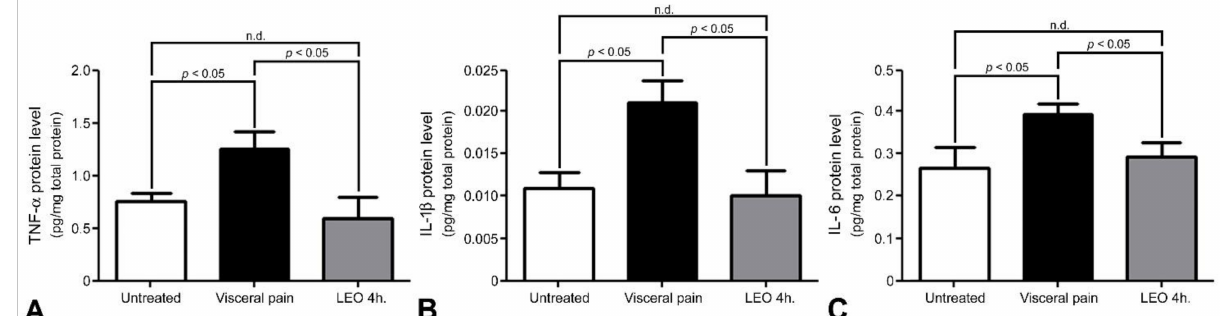
Figure 7. Histograms show the pro-inflammatory cytokine levels in the CeA of the untreated, visceral pain, and OS groups receiving LEO for 4 h. Note that visceral pain significantly increased TNF- α ( A ), IL-1 β ( B ), and IL-6 ( C ) concentrations in the CeA as compared to the untreated group. Also note that in animals suffered from visceral pain and who received LEO, the level of pro-inflammatory cytokines was successfully reduced in which no significant difference was detected between untreated and OS groups. n.d. = no significant difference.